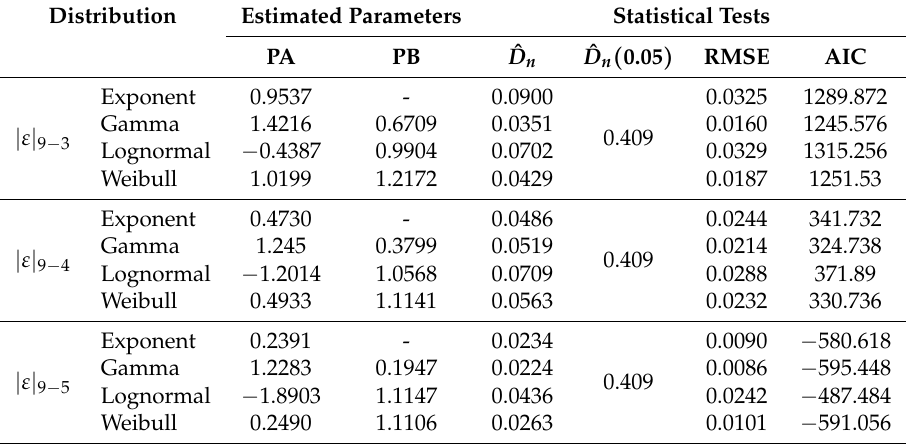
Table 5. Estimated parameters in the marginal distributions and results of statistical